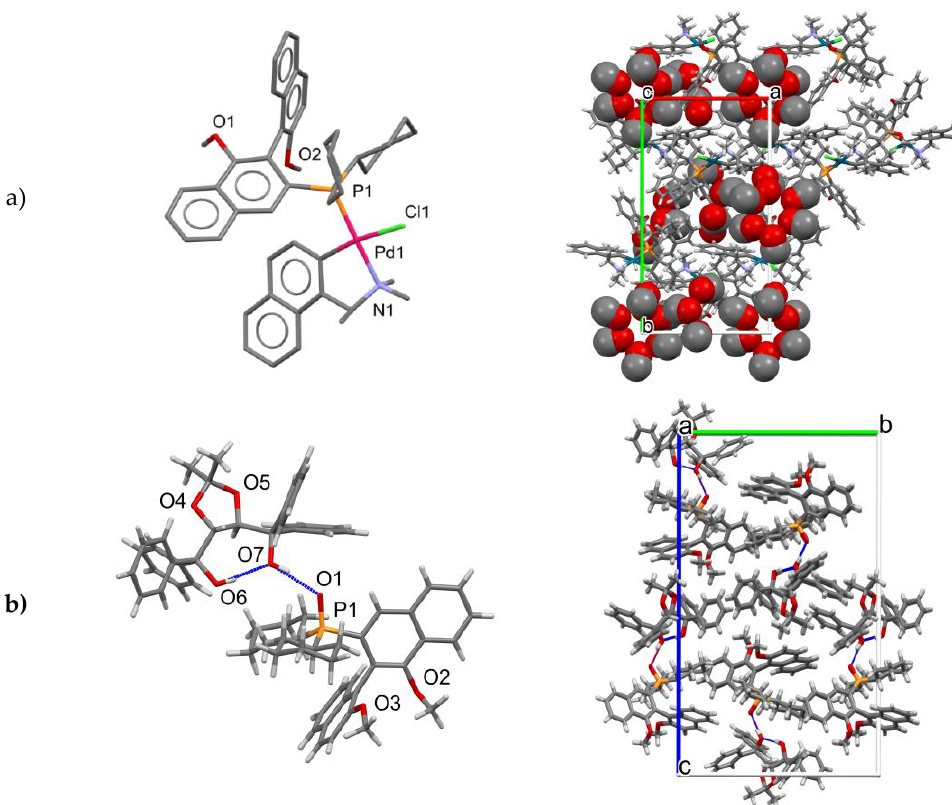
Figure 2. Molecular structure and crystal packing ( a ) of chiral palladium complex of BisNap -Phos and ( b ) of a cocrystal formed by compound 9 with TADDOL. The compound 12 was obtained as presented in Scheme 2.